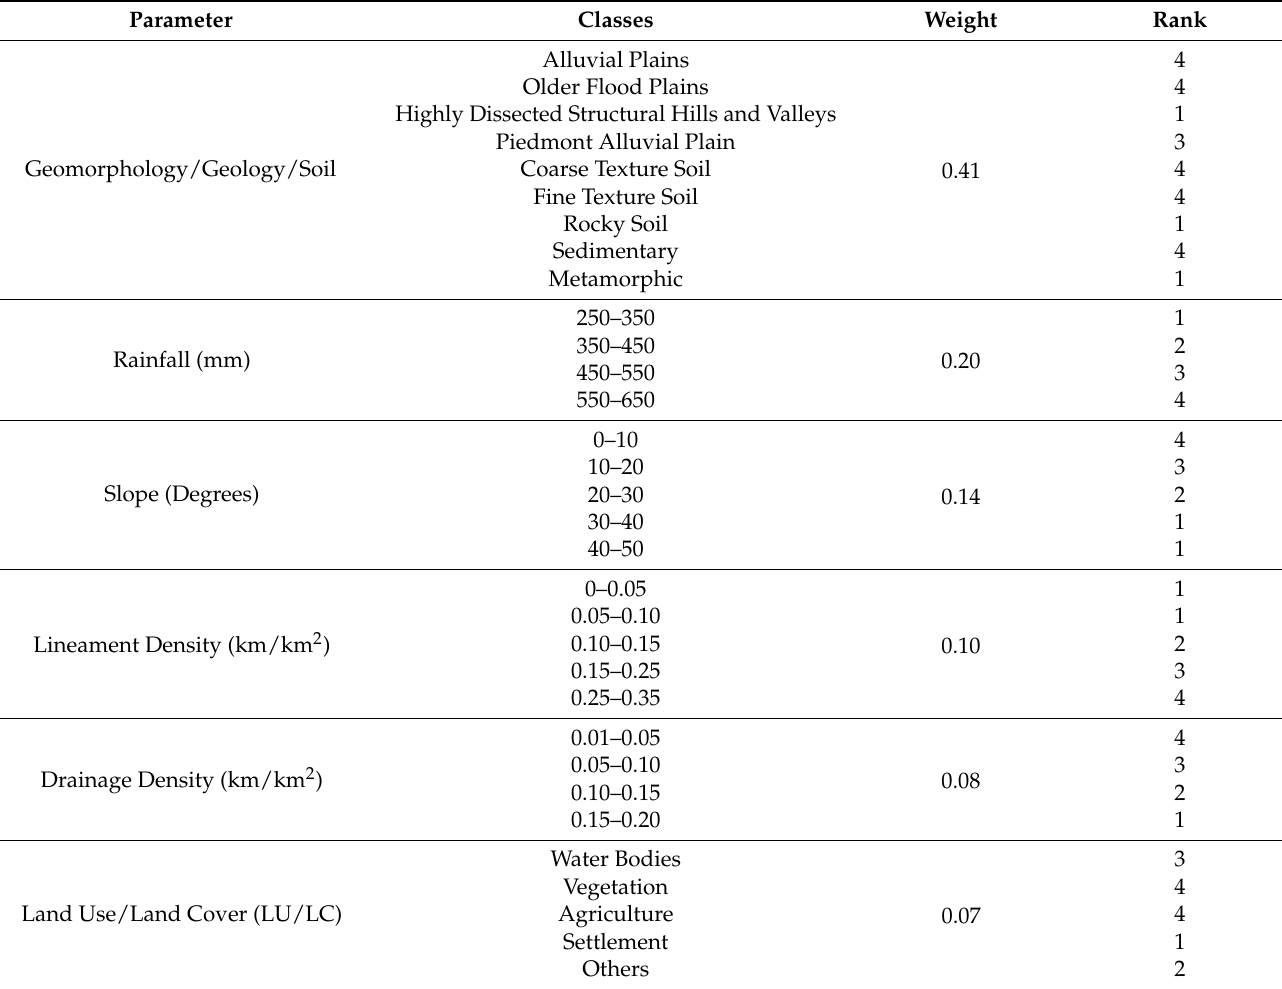
Table 7. Weights assigned for different parameters controlling/influencing groundwater in the study